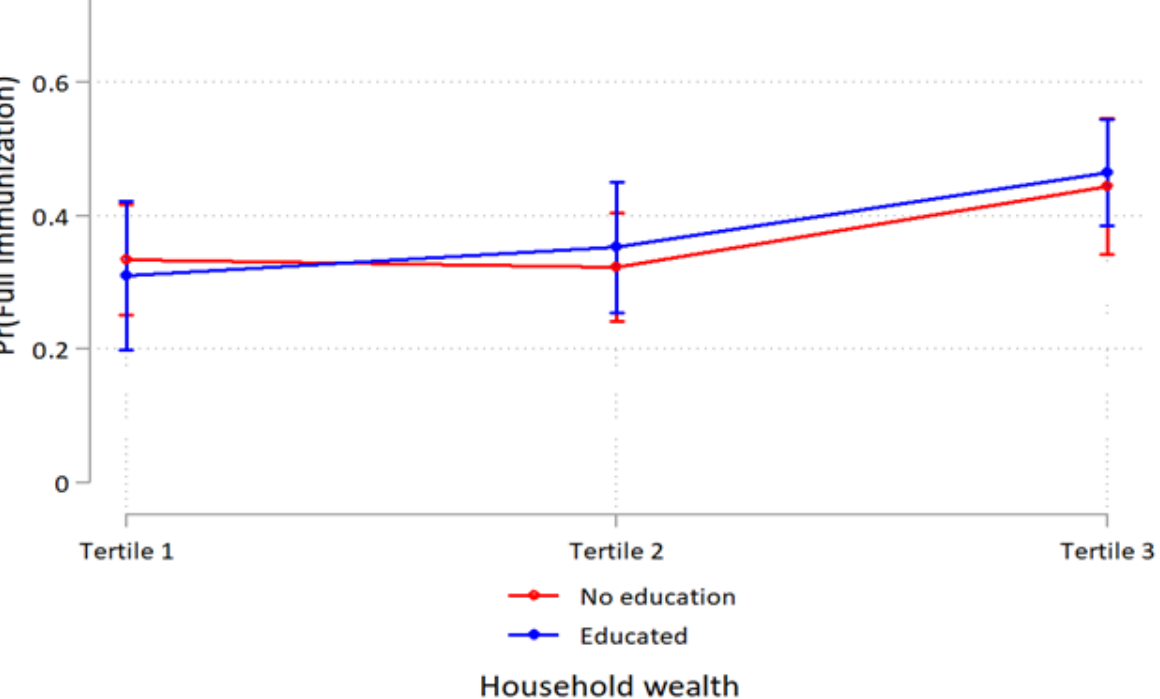
Figure 3. Probability of full immunization use by household wealth and maternal education with 95% confidence intervals.